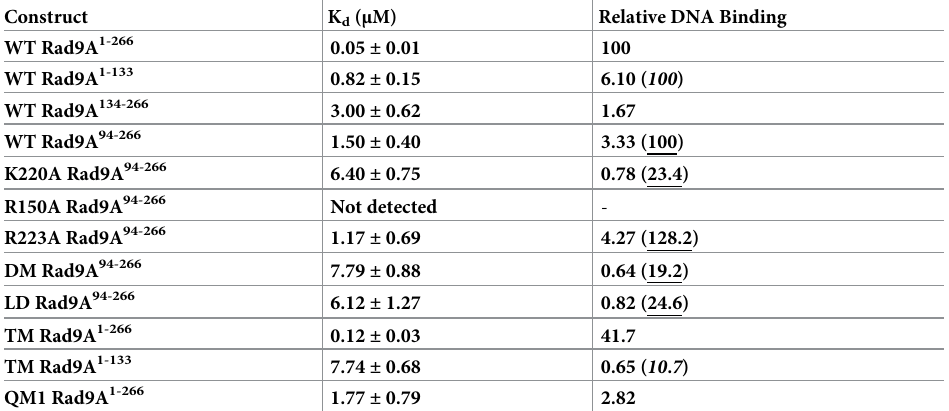
Based on the EMSA data (Fig 4), the Rad9A protein concentration which leads to 50% of band shift was estimated as K d . The results shown are the mean and standard deviation for three independent experiments. Relative DNA binding (fold) is calculated as compared to WT Rad9A 1-266 , WT Rad9A 94-266 (shaded yellow and underlined), or WT Rad9A 1-133 (shaded green and